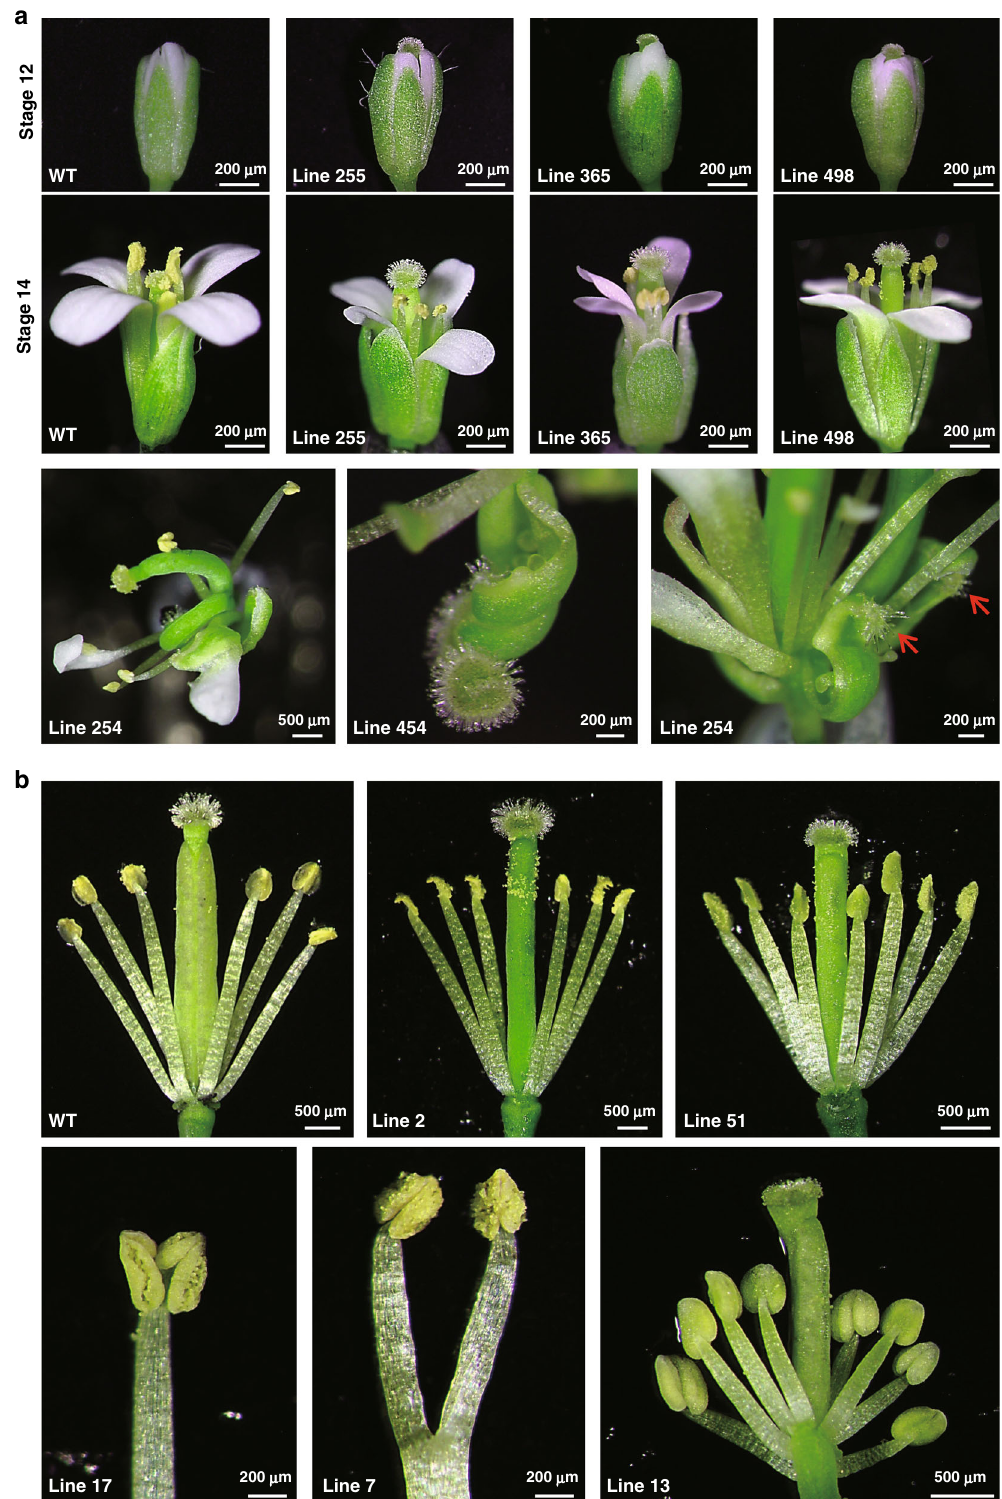
Fig. 5 Floral characterization of wild type and transgenic Arabidopsis plants. Each line number represents an independent transgenic line. a The fi rst and second row show the stigma hypertrophy and exsertion commonly observed in FERR -overexpressing plants; the third row shows extreme fl oral phenotypes observed in two FERR -overexpressing lines. A fl ower with two bent pistils (left) and one with carpel-like sepals (right, red arrow) were found in line 254, and line 454 (middle) produced a fl ower with one bent pistil and an unfused carpel. Due to the abnormal fl oral structures, it is dif fi cult to stage the fl owers in the third row from the top. However, by relying on the developmental stage of petals, stamens, and sepals, we classi fi ed these fl owers as late stages 15 – 16. b Dissected fl owers of wild type (WT) and MSL -overexpressing plants. WT fl owers have four long and two short stamens (tetradynamous stamen), whereas the fl owers from MSL -overexpressing plants had six long stamens (line 2), extra stamens (lines 51 and 13), or reduplicated Y-shaped stamens (lines 7 and